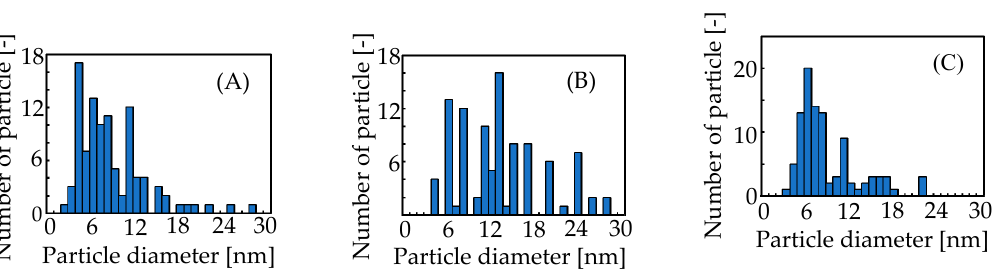
Figure 5. Particle size distribution of Ag on ( A ) Ag(56)-Na(1)/CaCO 3 , ( B ) Ag(56)-Na(1)/SrCO 3 , and ( C ) Ag(56)-Na(1)/MgCO 3 .